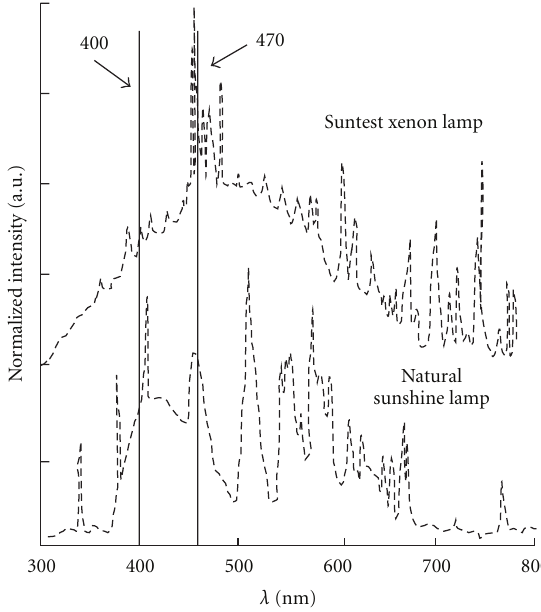
Figure 2: Emission spectra of the Xenon and natural sunshine lamps for interior lighting.